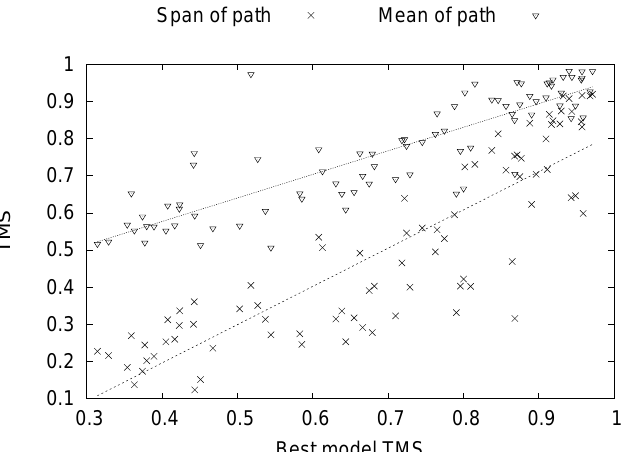
Figure 6. Mean (triangles) and span (x) of the path as a function of the best server model TMS submitted to CASP11. The Pearson correlation coefficients between the best model TMS and the mean/span of the path are 0.868/0.869, respectively. The correlation between the mean and the span of the path is 0.922. The best fit lines are presented to aid the eye. The line for the span of the path is given by l ( x ) = 1.03 x − 0.21. The line for the mean of the path is given by l ( x ) = 0.63 x +